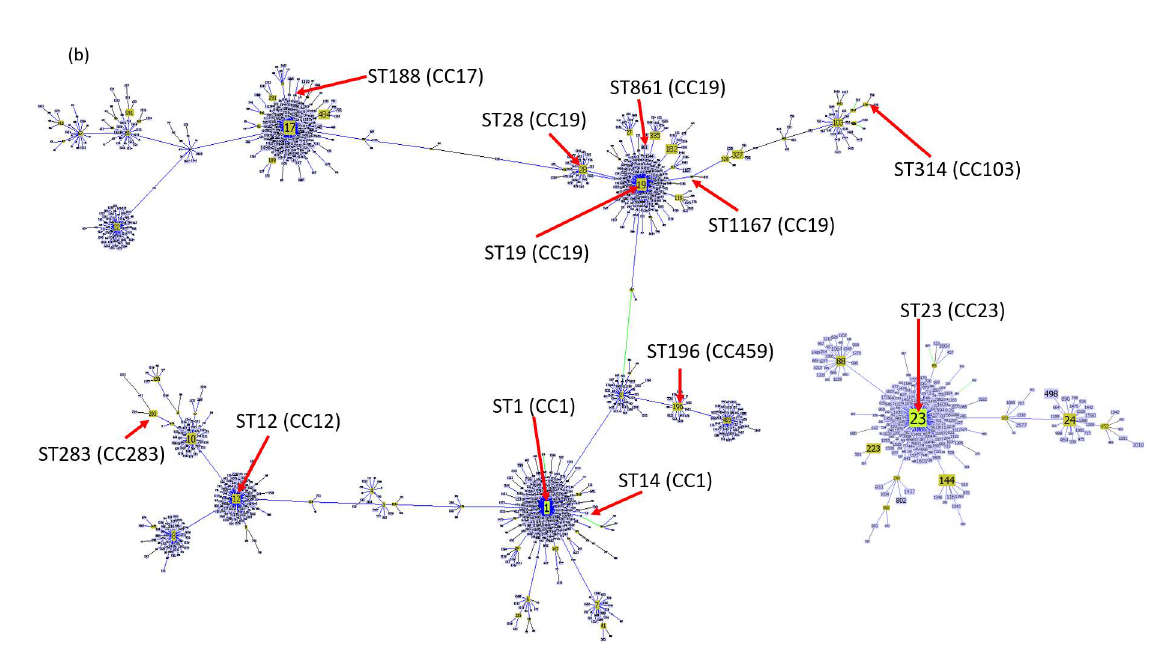
Figure 1. Dendrogram generated from 3456 base pairs concatenated multilocus sequence type (MLST) sequences of the 55 GBS isolates ( a ) and global optimal eBURST (goeBURST) analysis showing the clonal assignments of the obtained sequence types ( b ). MLST allelic profile, sequence type (ST), capsular polysaccharide (CPS) type, and clonal complex (CC) are also included in the dendrogram. As for goeBURST analysis, each ST is represented by a blue node. The central node represents the predicted ST founder shown in light green, while the subgroup founders are shown in yellow. The size of each node corresponds with the numbers of isolates in the STs database. Blue lines connect single-locus variants (SLV), and green lines connect double locus variants (DLV). CCs are identified by the number of the putative founder ST. Red arrows indicate the positions on the goeBURST analysis of each ST found in this study along with the corresponding CC in parenthesis. Table 1. Distribution of 55 selected Group B Streptococcus (GBS) classified by isolate source, age